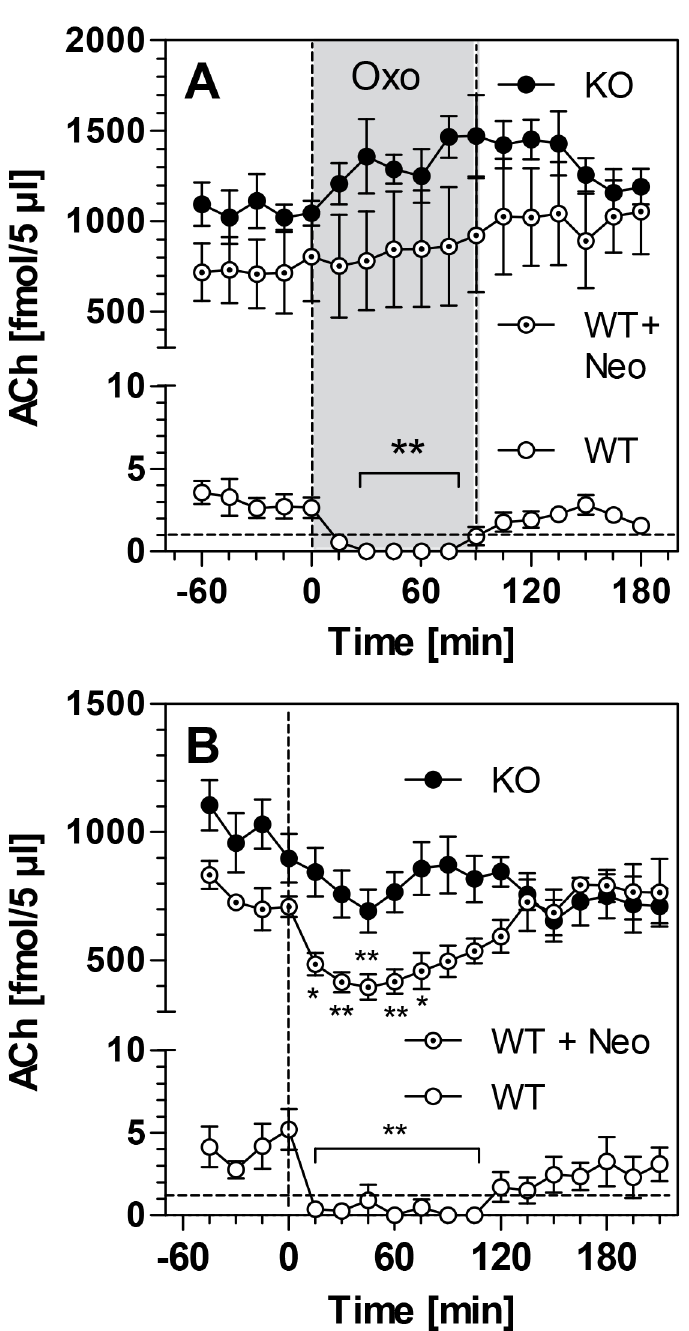
Fig 2. Acetylcholine (ACh) levels in murine striatum following administration of the M2 agonist oxotremorine. Data is presented for WT mice, WT+neo mice (group of WT mice additionally receiving 1 μ M neostigmine through the microdialysis probe to increase ACh levels) and PRiMA KO mice. Data is presented as means ± SEM of 4 – 6 experiments and given as absolute values, not corrected for in-vitro recovery. (A) ACh levels measured during oxotremorinee infusion (OXO, 100 μ M) indicated by grey area. (B) ACh levels measured after i.p. injection of oxotremorine (0.5 mg/kg) at time-point zero (dashed line). Statistical significance was calculated by One-way ANOVA with Dunnett´s Multiple Comparison Test, using time point "0 min" as reference. * , p < 0.05; ** , p < 0.01 vs. time zero. Raw data are given in S1 File.